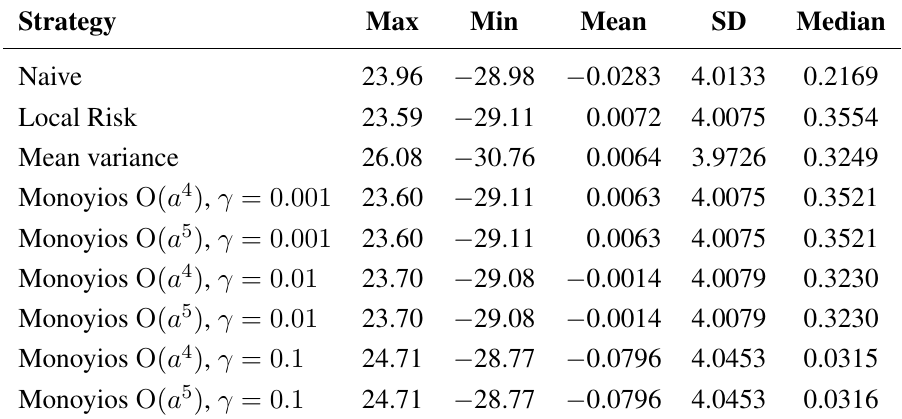
Table 3. Summary statistics of hedging error for the put option with parameters given by Table 1 and ρ = 0 . 95 .